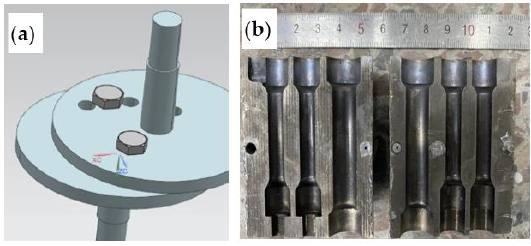
Figure 1. ( a ) Eccentric part of the planetary stirring structure and ( b ) the drawing of tensile sample mold. ple